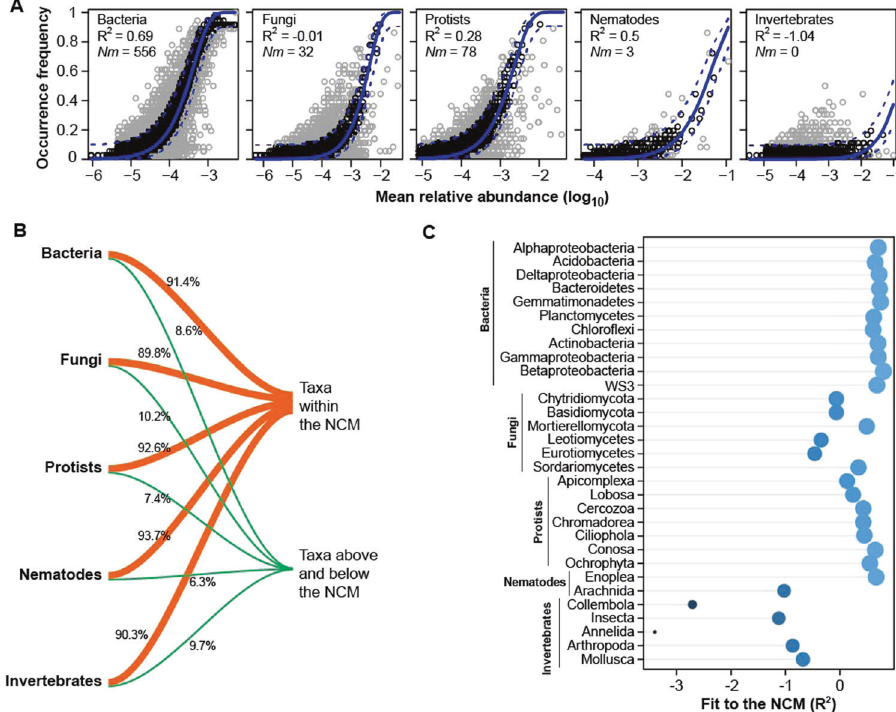
Fig. 3 Neutral community model fi t of fi ve taxonomic groups of soil biota along an urbanization gradient in Xiamen, China. A The R 2 re fl ects the strength of relationship between the occurrence frequencies and the relative abundance of, from left to right, bacteria, fungi, protists, nematodes, and invertebrates. The solid line indicates the fi tted model for the neutral community model and the dotted lines represent 95% con fi dence intervals above and below the model prediction. The Nm is the product of the metacommunity size ( N ) and the migration rate ( m ) indicating dispersal potential among the studied size-fractioned soil biota. B The percentages of taxa that perfectly fi tted the neutral community model, and taxa observed above and below the model prediction for each taxonomic group. C Class-level fi t-to-the model for the different phyla of the studied taxonomic